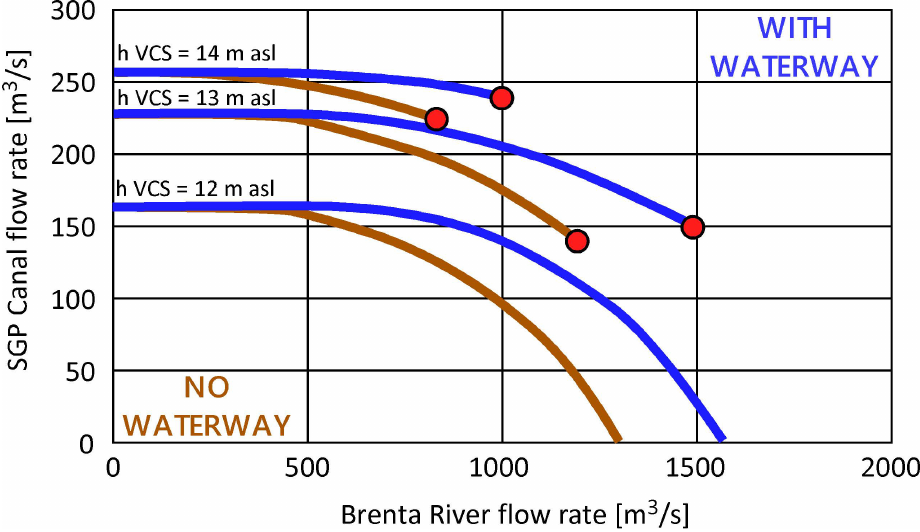
Figure 4. Maximum flow rates that can be conveyed through the SGP Canal into the Brenta River (i.e., gates of the Scaricatore facility were completely open) as a function of the flow rates in the Brenta River. Brown lines represent the current condition, blue lines represent the e ff ect of using the waterway of Padova–Venice as a diversion canal. Di ff erent set of lines refer to di ff erent water level upstream of the VCS; red circles denote the maximum discharge through the SGP Canal for which the levees are not